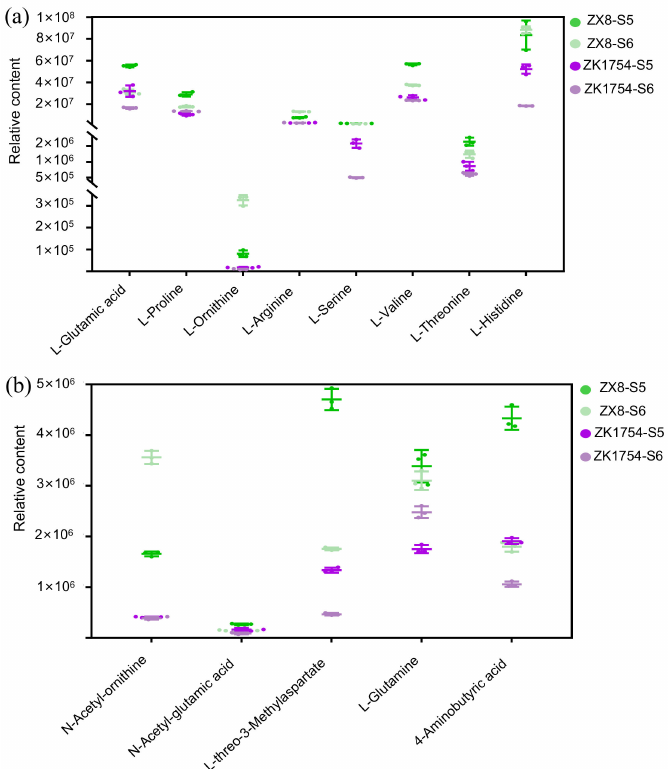
Figure 2. The content comparison of amino acids in ZX8 and ZK1754. ( a ) Plots of relative contents of amino acids accumulated at relatively high levels in ZX8 grain with three biological replicates for metabolite analysis. ( b ) Plots of relative contents of amino acid derivatives accumulated at relatively high levels in ZX8 grain with three biological replicates for metabolite analysis.